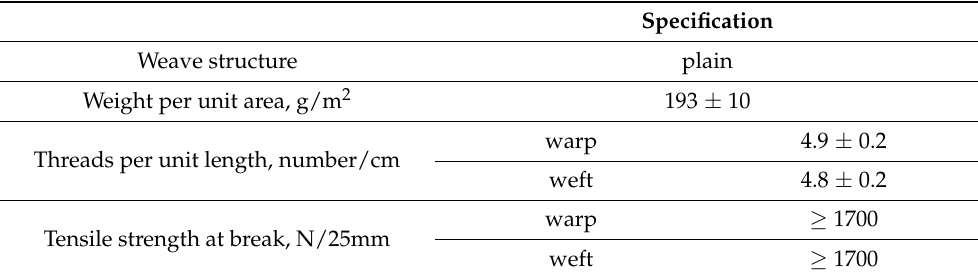
Table 2. Specification of carbon fiber fabrics CF3011 used.